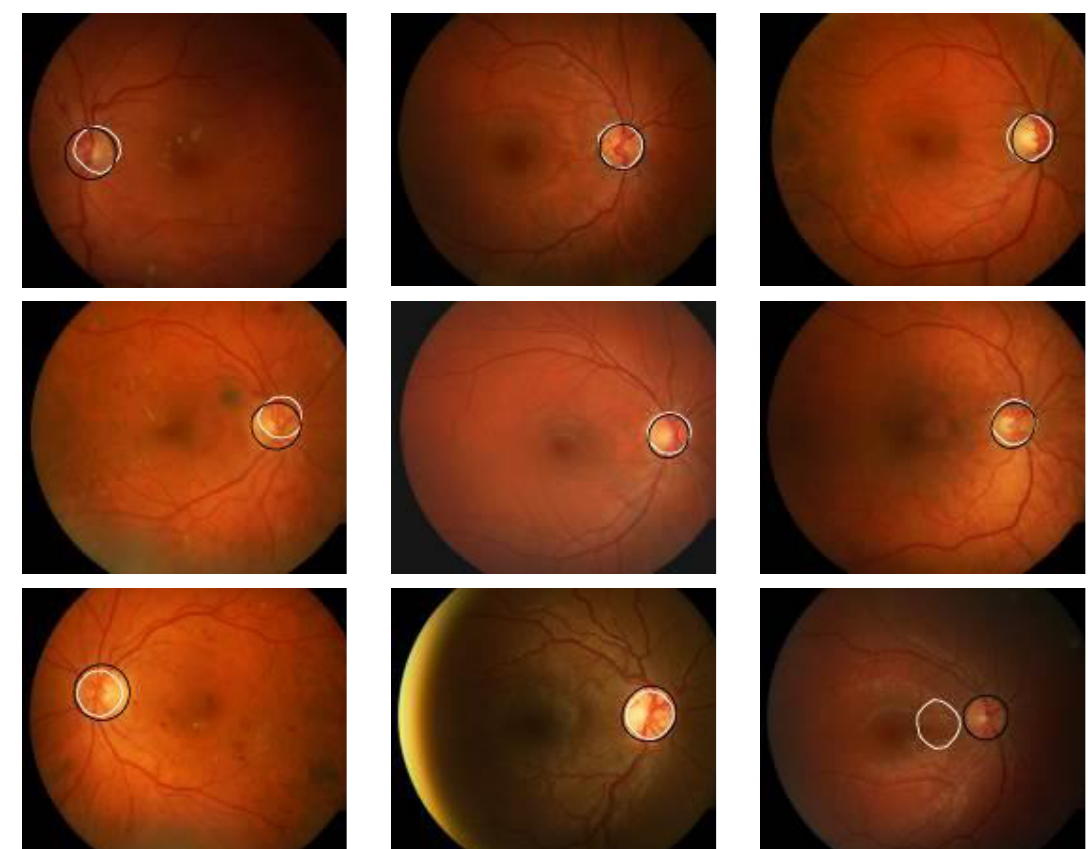
Figure 10. Results obtained for proposed method on DIARETDB1 dataset images. Detected boundary of optic disc is shown by white curve, and ground truth is shown by black